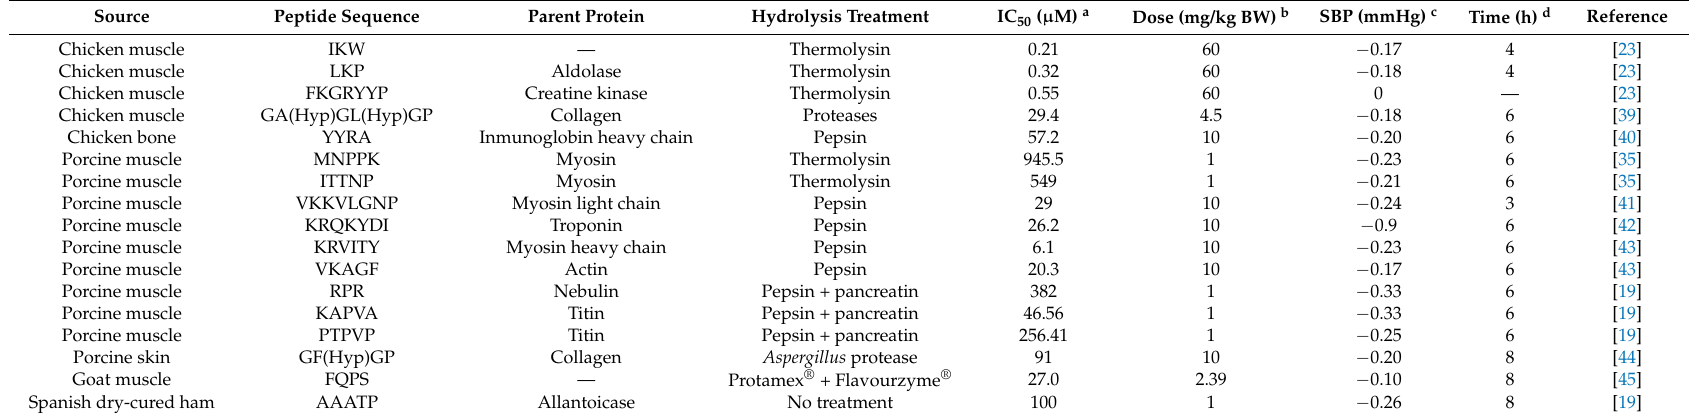
Table 1. Angiotensin I-converting enzyme (ACEI)-inhibitory peptides identified in meat and meat products with antihypertensive effects in spontaneously hypertensive